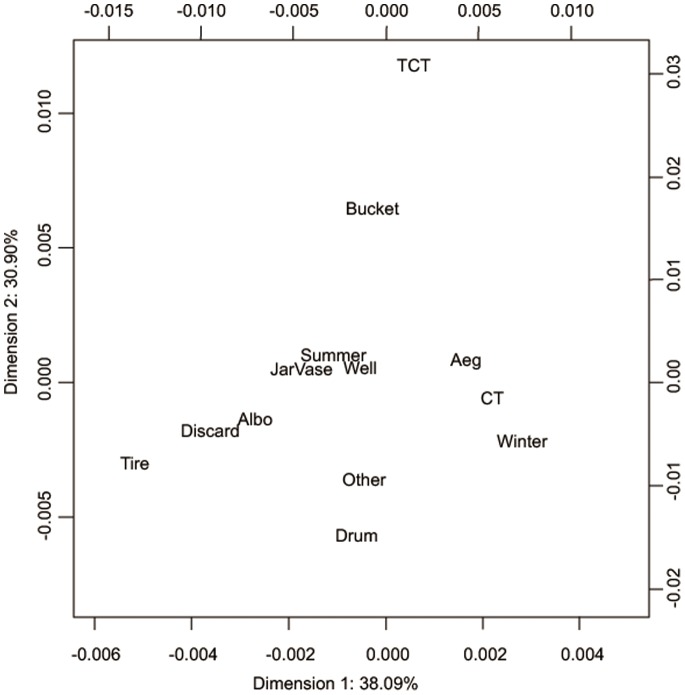
Multiple correspondence analysis of mosquito species, season, and container type.Mosquito species (Ae. aegypti and Ae. albopictus), season (summer and winter), and container type (bucket, concrete tank, discarded container, drum, jar, other containers, tire, toilet concrete tank, and flower vase). Mos. aeg; Ae. aegypti, Mos. albo; Ae. albopictus, C.; Container, CT; concrete tank, Discard; discarded container, Other; other containers, S; Summer, TCT; toilet concrete tank, W; Winter.